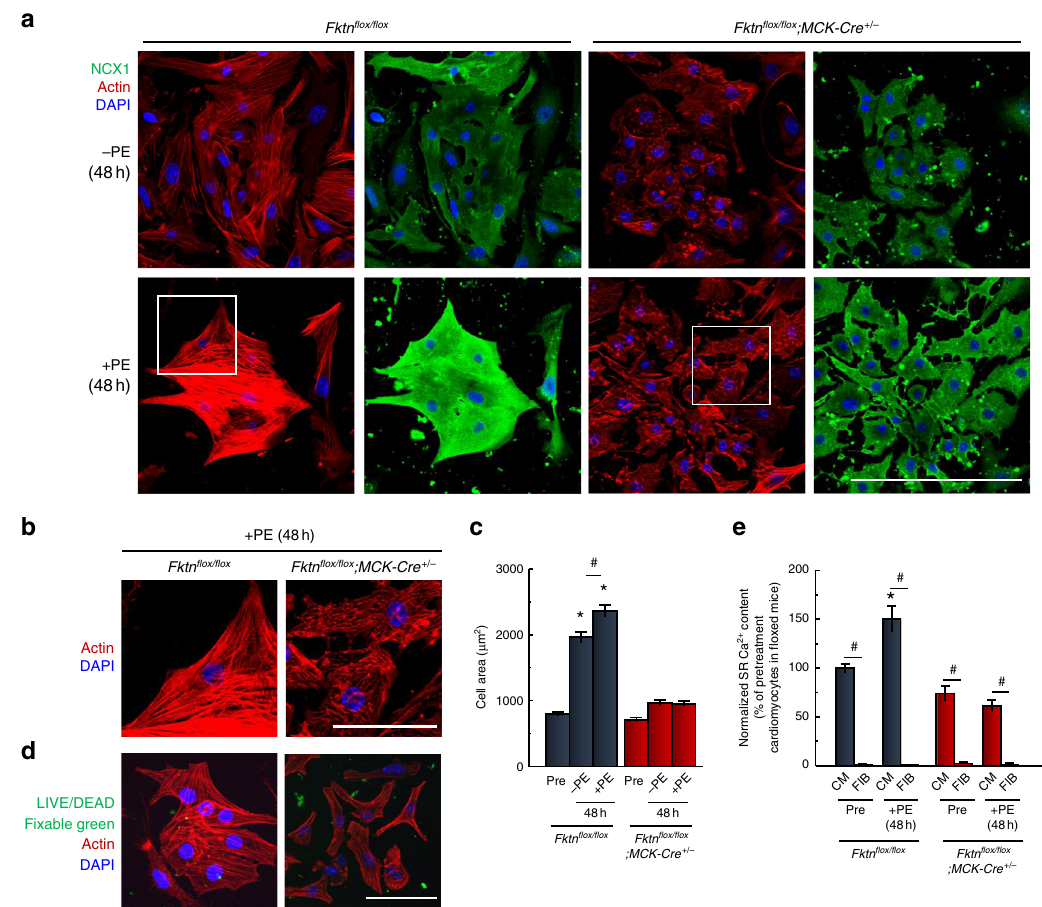
Fig. 4 Impaired hypertrophic responses of MCK- Fktn -cKO ( Fktn fl ox/ fl ox ; MCK-Cre + / − ) cardiomyocytes. a Representative immuno fl uorescence images of neonatal cardiomyocytes cultured with or without phenylephrine (PE) for 48 h (NCX1, green; phalloidin, red; DAPI, blue). Scale bar, 200 μ m. b Magni fi ed view of white squares in a . Scale bar, 50 μ m. c Change in cell area of PE-treated cardiomyocytes (Pre, n = 106 cells; − PE, n = 98 cells; + PE, n = 96 cells from 10 hearts isolated from fl oxed mice. Pre, n = 59 cells; − PE, n = 87 cells; + PE, n = 113 cells from 10 hearts isolated from MCK- Fktn -cKO mice.). * P < 0.05 vs. cardiomyocytes before treatment with PE (Pre) isolated from fl oxed or MCK- Fktn -cKO mice and MCK- Fktn -cKO myocytes treated with or without PE; # P < 0.05 between indicated groups based on Tukey – Kramer tests. d Viability of cardiomyocytes from fl oxed or MCK- Fktn -cKO hearts. Confocal microscope images, LIVE/DEAD assays for myocytes cultured for 48 h. Scale bar, 100 μ m. e Estimation of SR Ca 2 + content (Pre-CM, n = 52 cells; Pre-FB, n = 13 cells; + PE-CM, n = 50 cells; + PE-FB, n = 26 cells from 10 hearts isolated from fl oxed mice. Pre-CM, n = 33 cells; Pre-FB, n = 46 cells; + PE-CM, n = 45 cells; + PE-FB, n = 23 cells from 10 hearts isolated from MCK- Fktn -cKO mice.). CM cardiomyocytes, FIB fi broblasts. * P < 0.05 vs. cardiomyocytes before treatment with PE (Pre) isolated from fl oxed mice; # P < 0.05 between indicated groups based on Tukey – Kramer